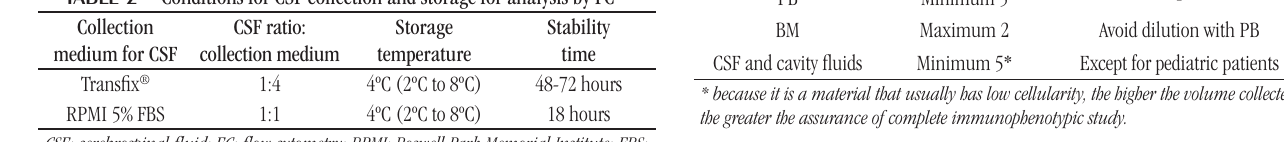
taBLE 3 − Recommended volume of biological samples for analysis by FC Material